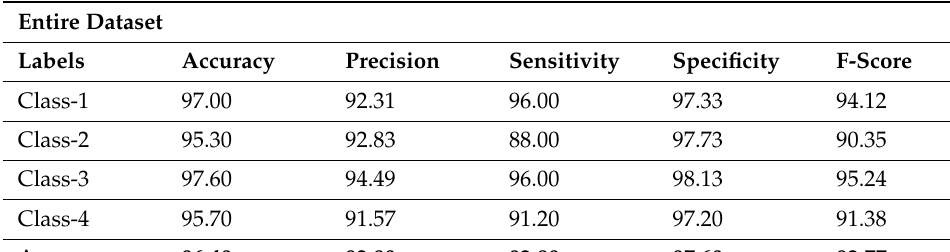
Table 2. Crowd classification outcome of the AOTL-CDA3S system with different measures under the entire database.